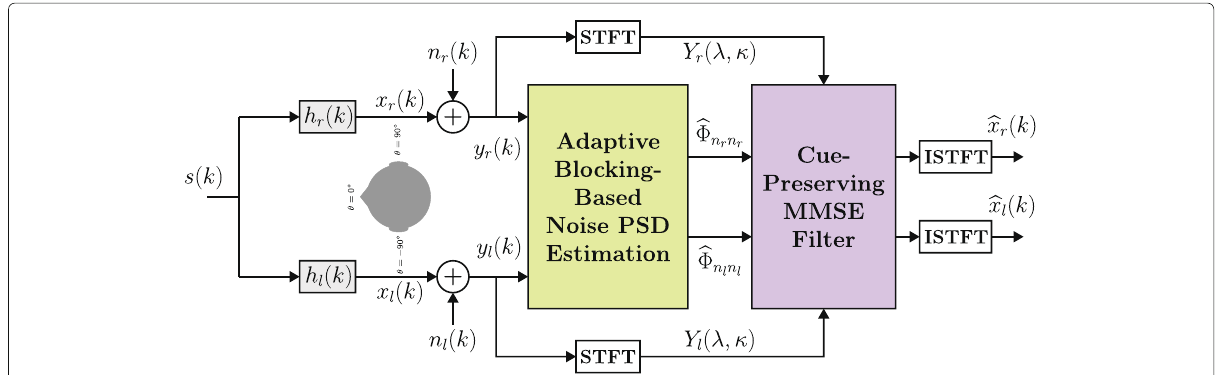
Fig. 1 Schematic block diagram of the proposed binaural noise reduction